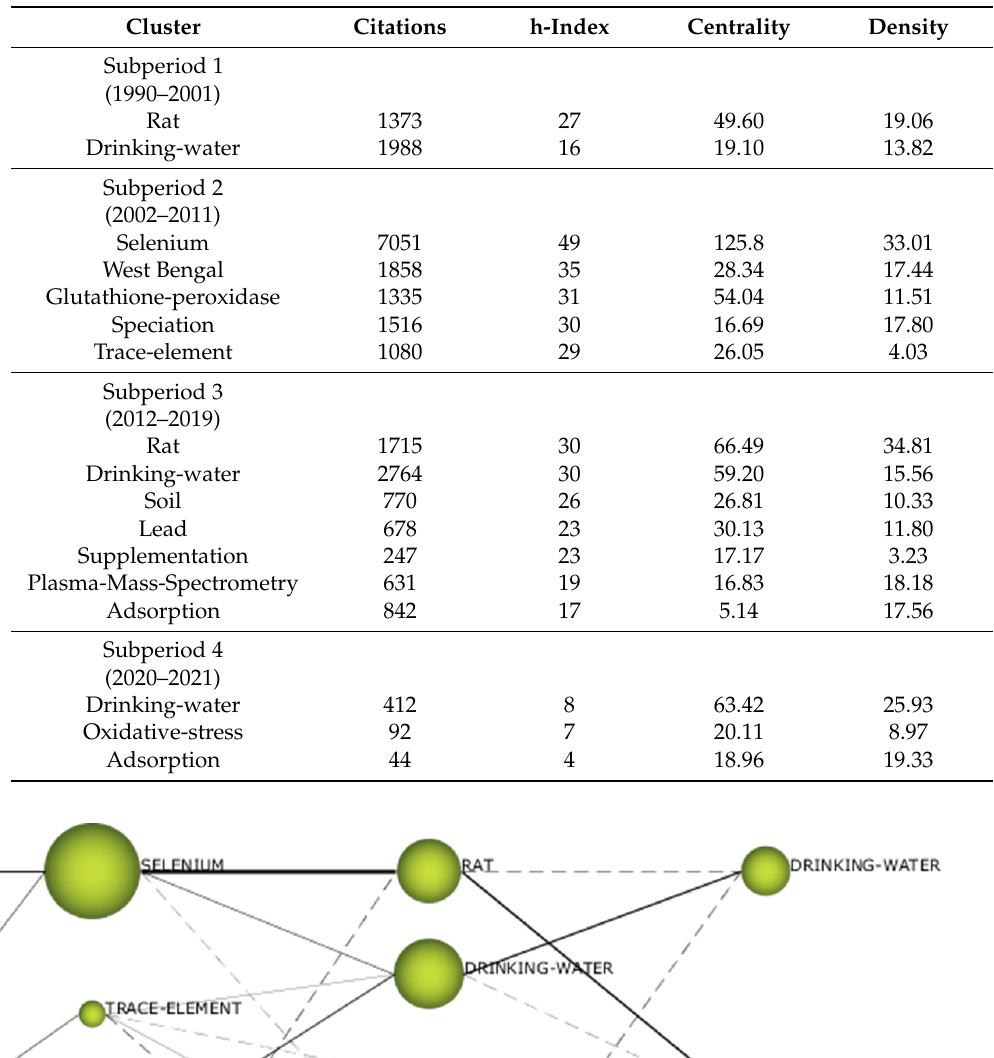
Table 7. Citations, h-indexes and centrality and density values of the different clusters identified in the bibliometric network analysis.